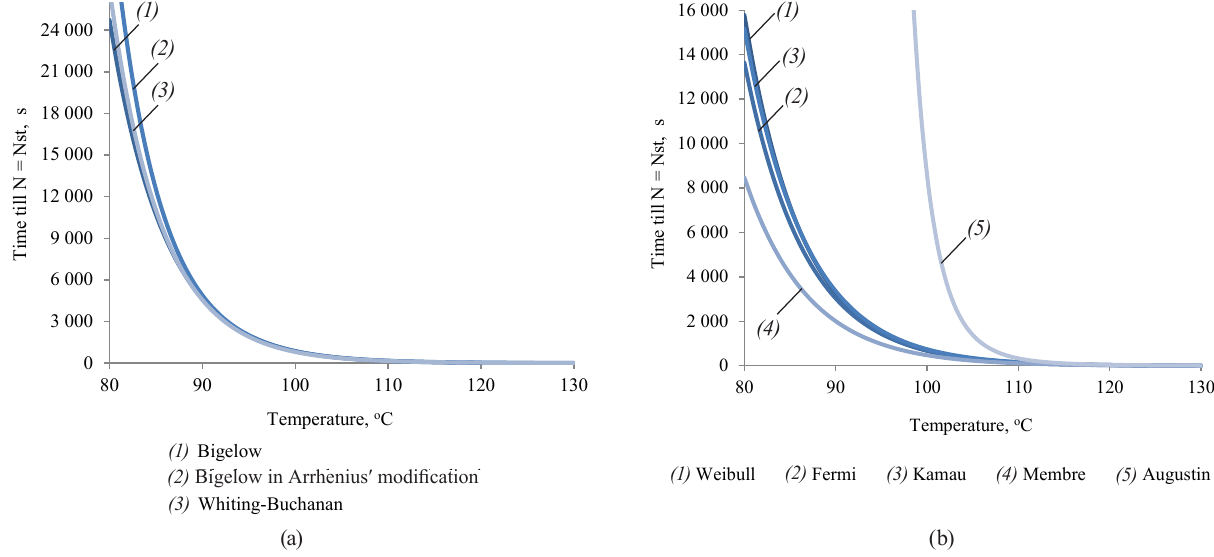
Figure 13 Dependence of starting treatment duration required for concentration of surviving A. acidoterrestris to reach N sterilisation temperature for linear (a) and nonlinear (b) models